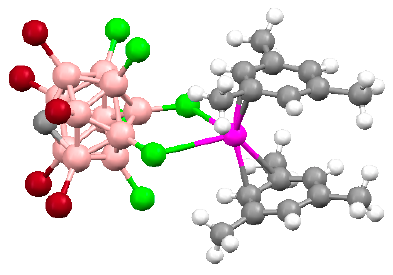
Figure 73. X-ray structure of {( η 2 -mesitylene) 2 Ag[1-HCB 11 -2,3,4,5,6-Br 5 -7,8,9,10,11,12-Cl 6 ]}. In contrast, a polymeric structure is observed in ({( η 1 -mesitylene)Ag[1-HCB 11 -2,3,4,5,6-Cl 5 -7,8,9,10,11,12-Br 6 ]}·mesitylene) n . The four-coordinated silver atom is in a distorted tetrahedral arrangement of one η 1 -mesitylene molecule, two bromine atoms from a bridging [1-HCB 11 Cl 5 Br 6 ] − anion and one bromine atom from another bridging [1-HCB 11 Cl 5 Br 6 ] − anion (the Ag…Br distances of 2.750(2)–2.873(1) Å) (Figure 74) [99]. There are no interactions between Ag + and any one of the five chlorine atoms from the upper belt of the carborane cage, which is understandable because Br − is a softer base than Cl − and the lower belt atoms bear more negative charge than the upper belt ones. These results may suggest that the charge distribution on the icosahedral cage plays a predominant role in the coordination chemistry of carborane anions.